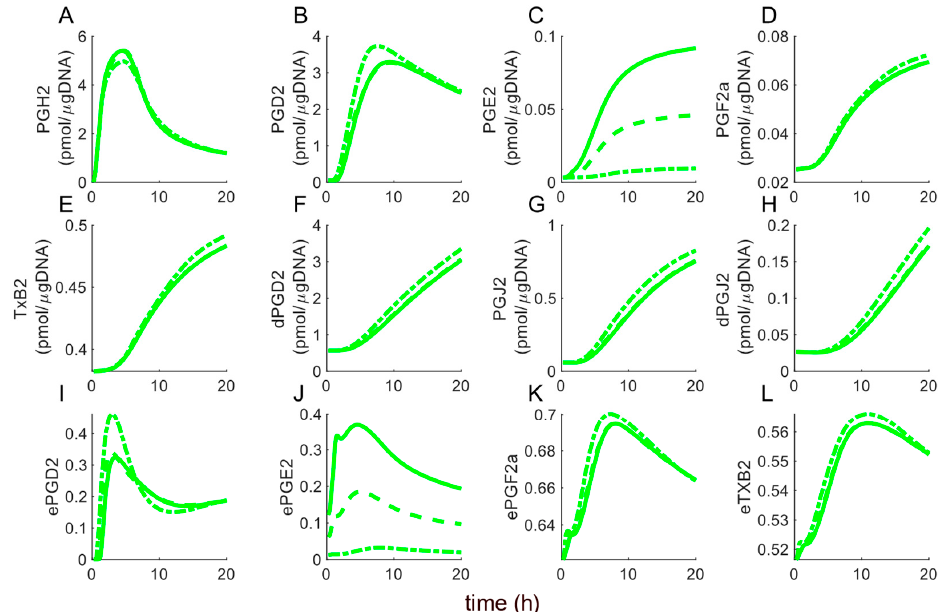
Figure 8. Gene knockdown perturbation profiles for PRs branch for measured metabolites and intermediates ( A – H ) and enzymes ( I – L ). A simulated enzyme perturbation to the PGE 2 branch of the network alters the Ptges (ePGE 2 ) enzyme levels. A lower f value corresponds to a decrease in the constitutive and inducible enzyme synthesis rates of ePGE 2 ( J ), and it reduces the flux of PGE 2 . The fluxes of PGD 2 , PGF 2a , and TxB 2 increase because the flux inflow from AA to PGH 2 is unchanged. We observed the lower concentrations of PGE 2 ( C ) and higher levels of PGD 2 ( B ), PGF 2a ( D ), and TxB 2 ( E ) as f decreases, as expected. The decreased PGH 2 level ( A ) in response to lower f is because of the increased PGD 2 flux, which is the dominant metabolite. Additionally, the increased flux of PGD 2 leads to an increase in the concentration of downstream PGD 2 products: dPGD 2 ( F ), PGJ 2 ( G ), and dPGJ 2 ( H ). We observe a slight increase in enzyme levels for the other metabolites (ePGD 2 ( I ), ePGF 2a ( K ), eTxB 2 ( L )) because of increased corresponding metabolite levels.